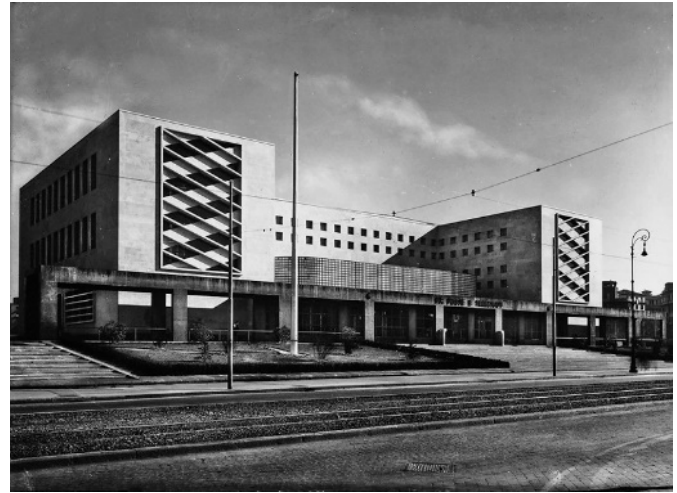
Figure 10. Post Office building by Adalberto Libera and Mario De Renzi. Rome (1933–1935). Photo from (Pica 1936, p. 301).